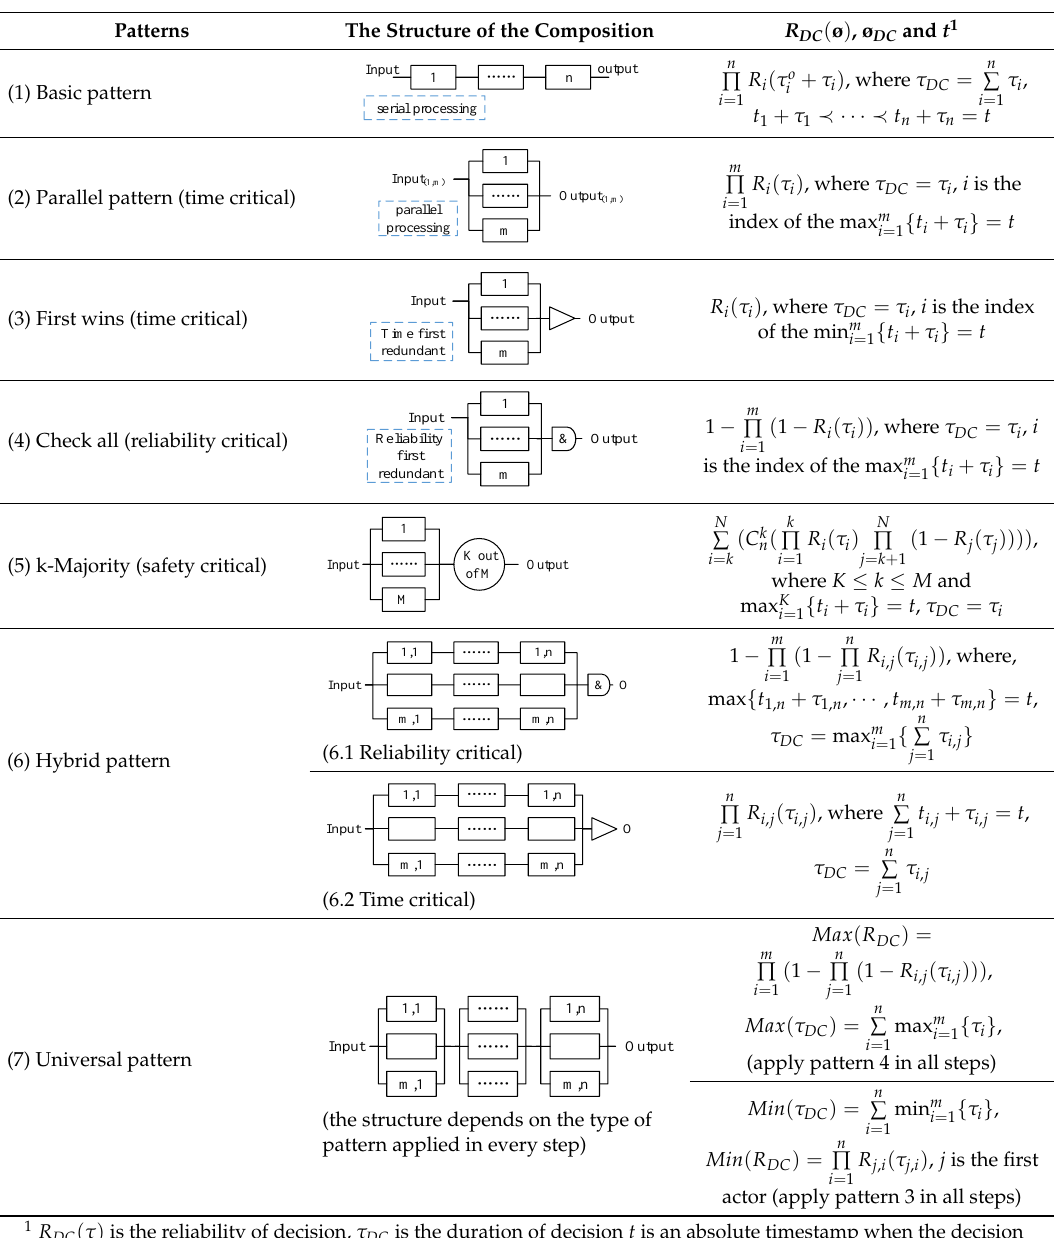
Figure 16. Static processing on macrosystem.